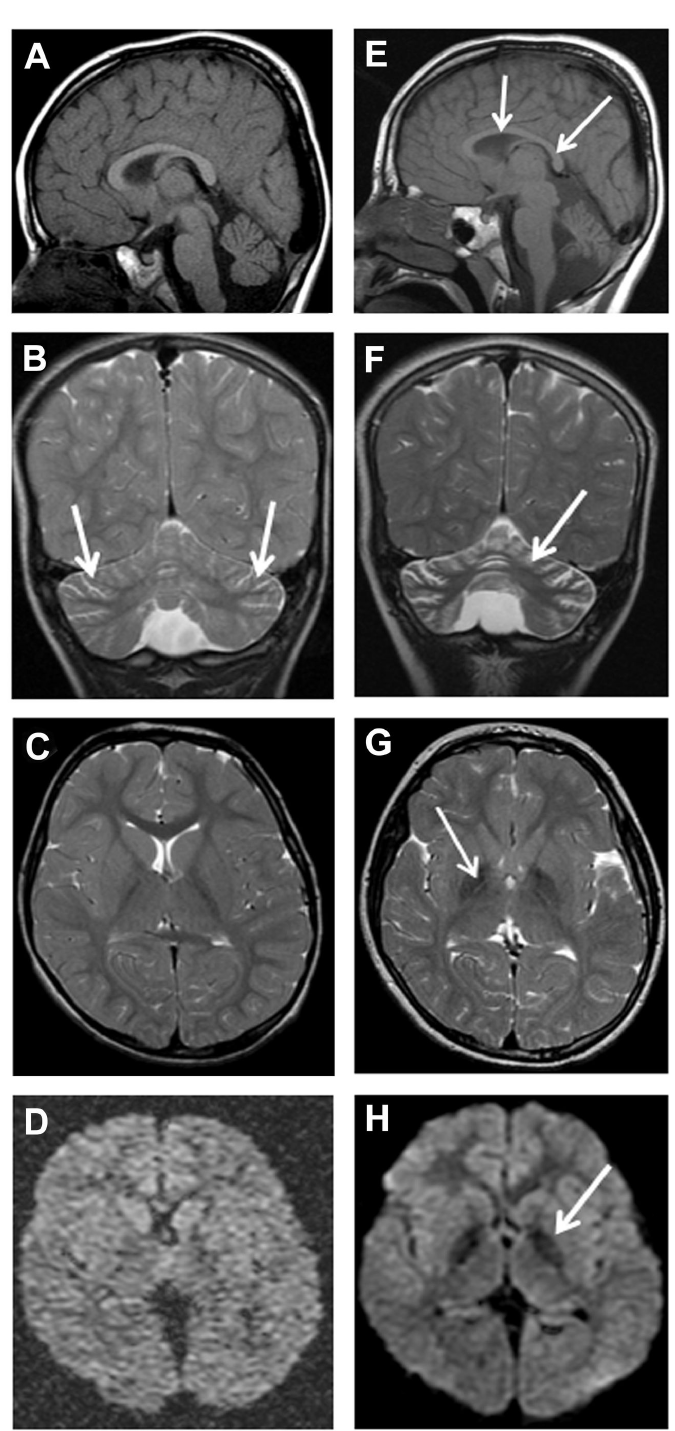
Figure 2. Patient F5 (P1) MRI, age 4 years 2 months (A-D), and 7 years 6 months (E-H). Sagittal T1-weighted (A and E), coronal T2-weighted (B and F), axial T2-weighted (C and G) and axial diffusion (D and H) sequences showing mild cerebellar cortical atrophy with mildly prominent folia (arrows in C). There is also simple corpus callosum (arrows in E). (F) Coronal T2- weighted reveals progressive cerebellar cortical atrophy and gliosis, with widening of folia and increased signal in the residual cerebellar cortex (arrow). Axial T2-weighted (G), and axial diffusion (H) sequences highlight iron deposition as reduction in signal intensity in the globus pallidi (arrows). doi: 10.1371/journal.pone.0076831.g002 PLOS ONE |